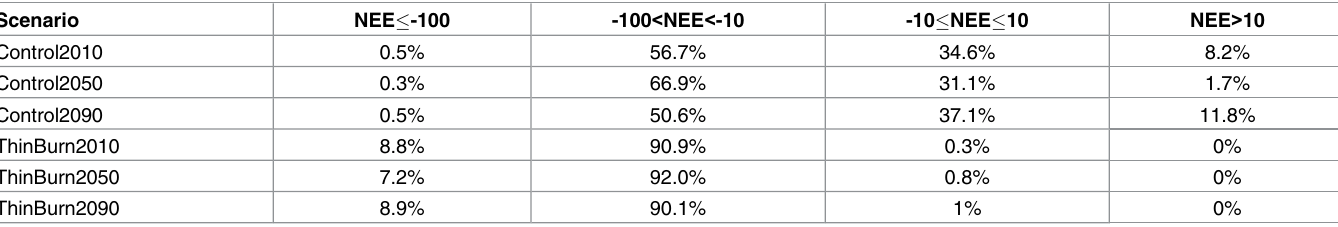
Table 2. Percentage of the landscape that had cumulative net ecosystem exchange (NEE, Mg C ha -1 ) that was a strong carbon sink (NEE (cid:20) -100), a moderate carbon sink (-100 < NEE < -10), had little net change in carbon (-10 (cid:20) NEE (cid:20) 10), or was a carbon source (NEE > 10).